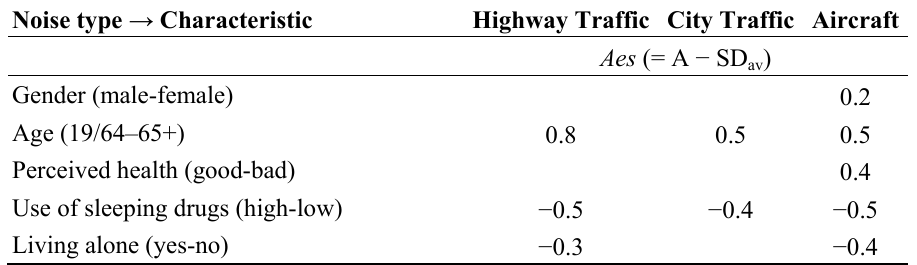
Table 5. Differences in Annoyance excess score ( Aes ) in relation to individual characteristics. Values shown only when difference is significant ( p <